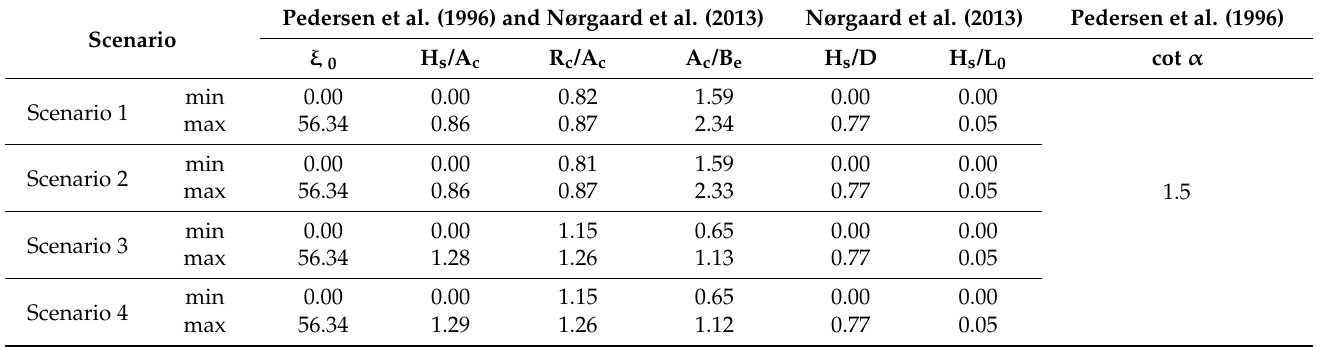
Table 10. Parameter range for Pedersen et al. (1996) and Nørgaard et al. (2013).